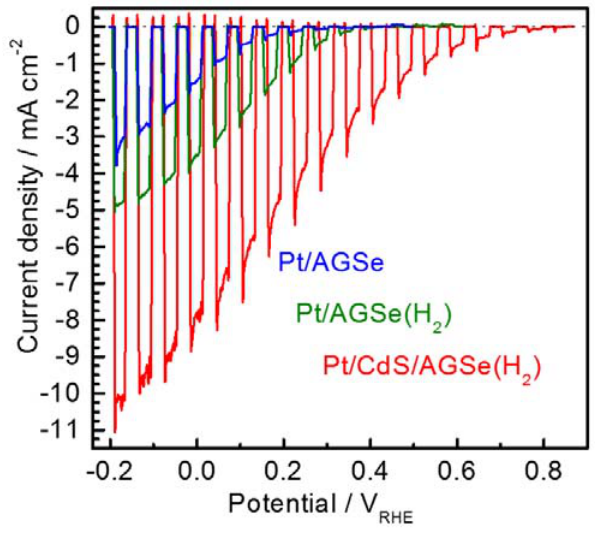
Figure 10. Current-potential curves for Pt/AGSe, Pt/AGSe(H 2 ), and Pt/CdS/AGSe(H 2 ) electrodes. A 0.1 M aqueous Na 2 SO 4 solution (adjusted to pH 9 by NaOH addition) was employed as the electrolyte.